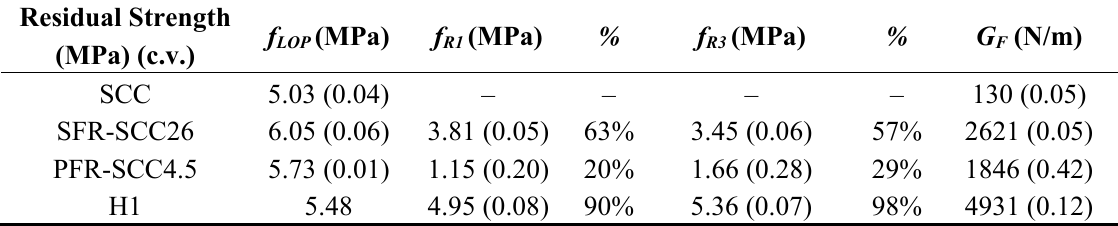
Table 5. Residual strengths of